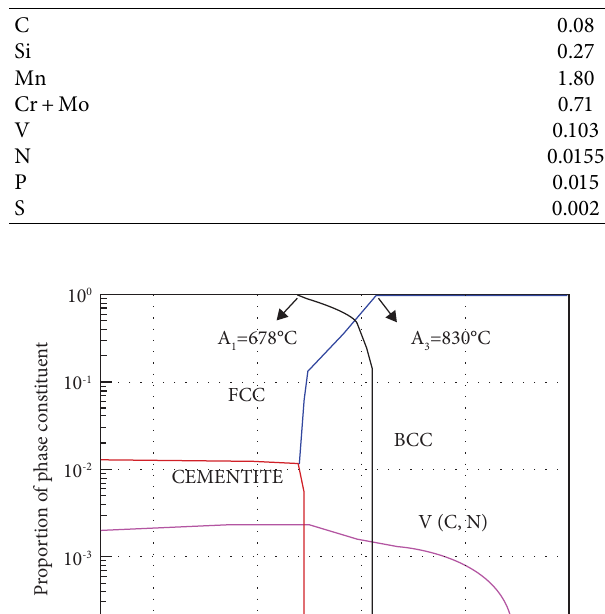
Table 1: Chemical composition of experimental steel (wt%).